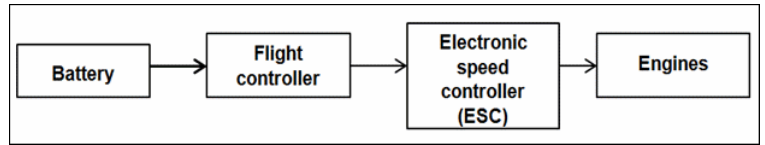
Figure 5. Simplified scheme for the battery-powered UAV.